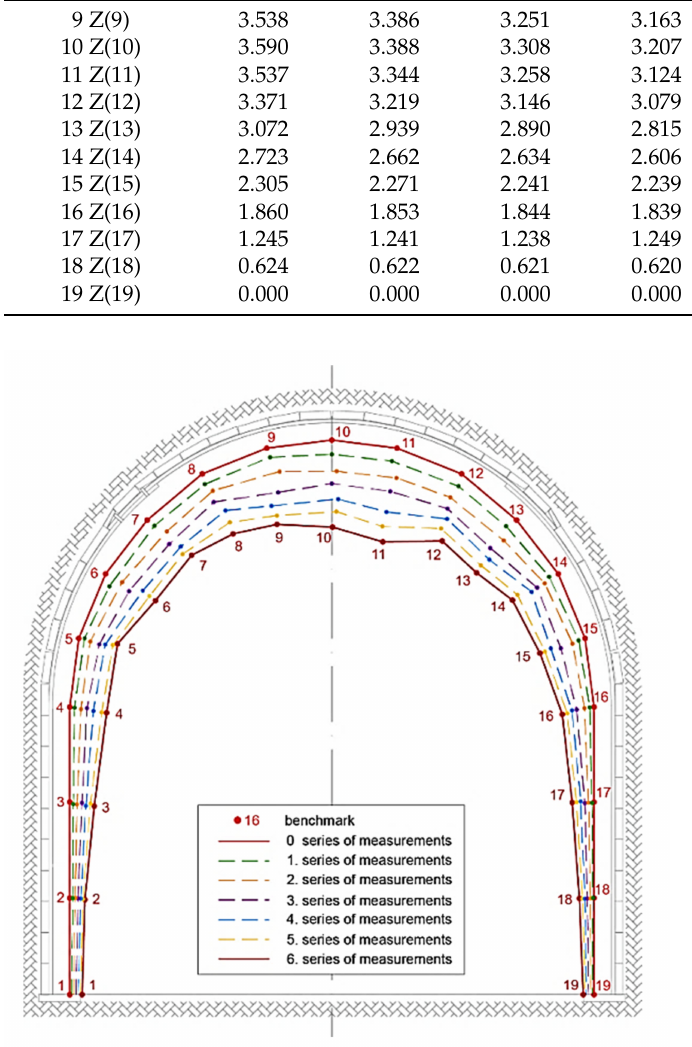
Figure 6. Configuration of the gate road support over the time of observation. Measurements for t = 0, 1, . . . , 5 are used to create a forecast model, while the measurement for t = 6 is used as a control series. Detail calculation is provided for the x coordinates. Figure 7 represents x coordinates of the marker 10 obtained by